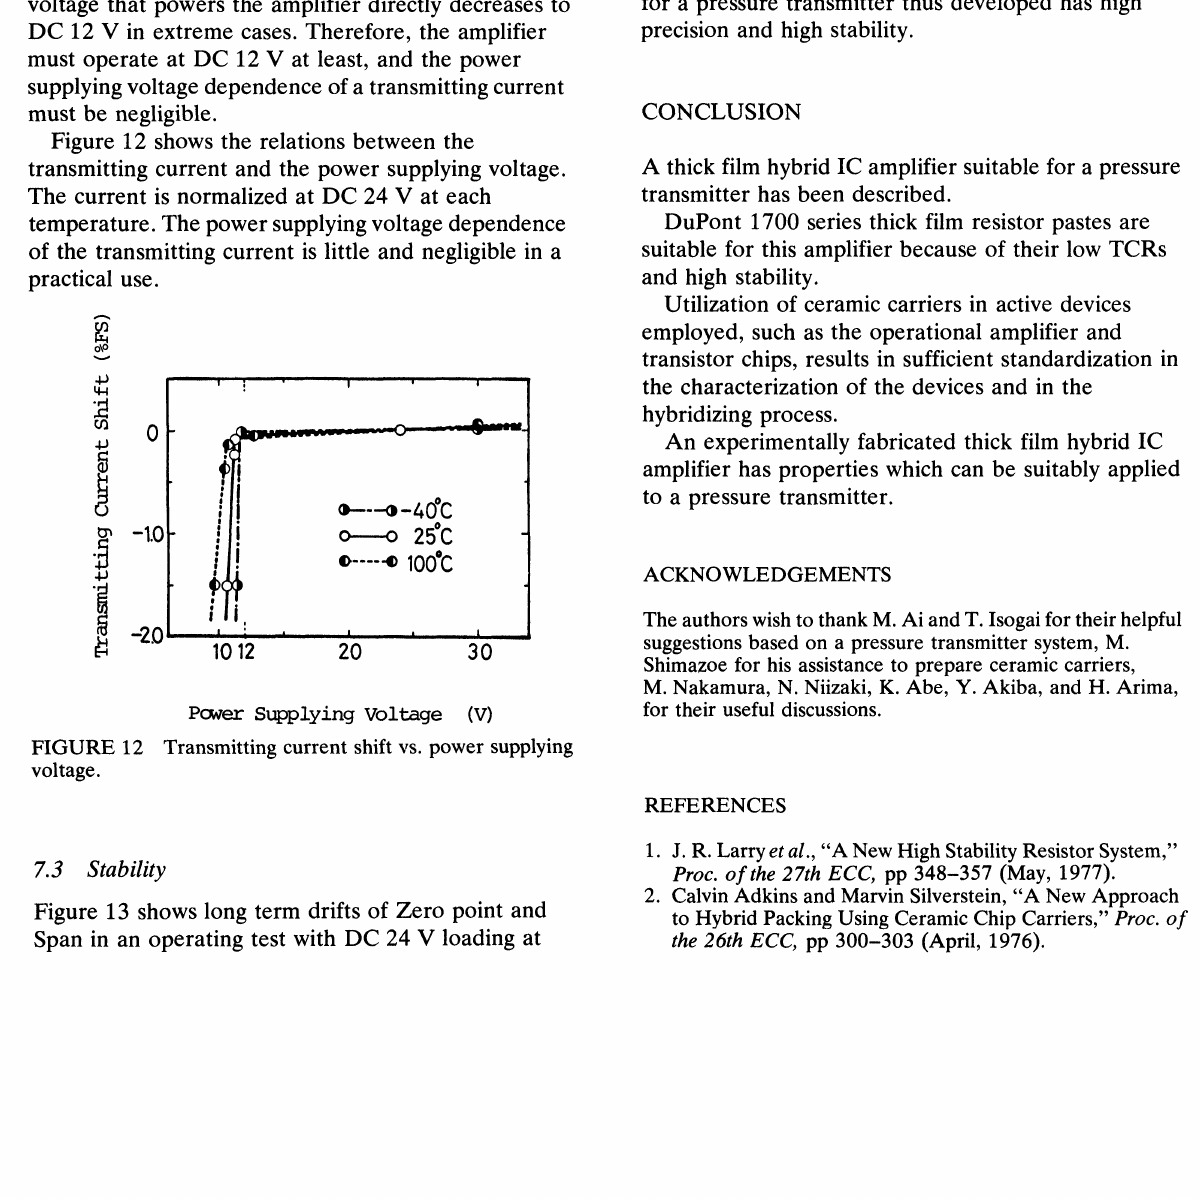
FIGURE 11 Span shift vs. temperature.